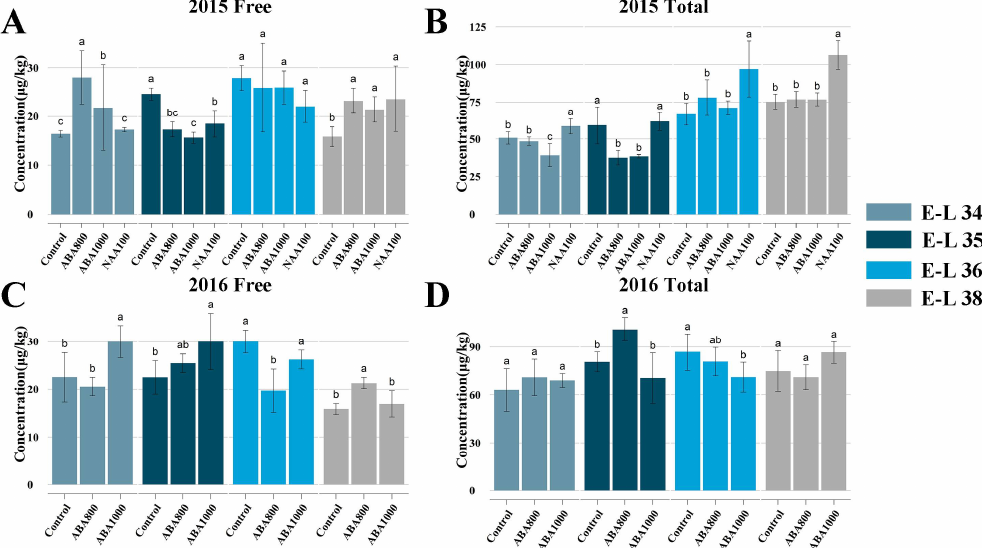
Figure 5. Concentrations of free, total and individual norisoprenoids. ( A ) Concentrations of free norisoprenoids in 2015. ( B ) Concentrations of total norisoprenoids in 2015. ( C ) Concentrations of free norisoprenoids in 2016. ( D ) Concentrations of total norisoprenoids in 2016. Statistical analysis involved the comparison of treatments at each E-L stage, and different letters represent significant differences ( p =0.05).